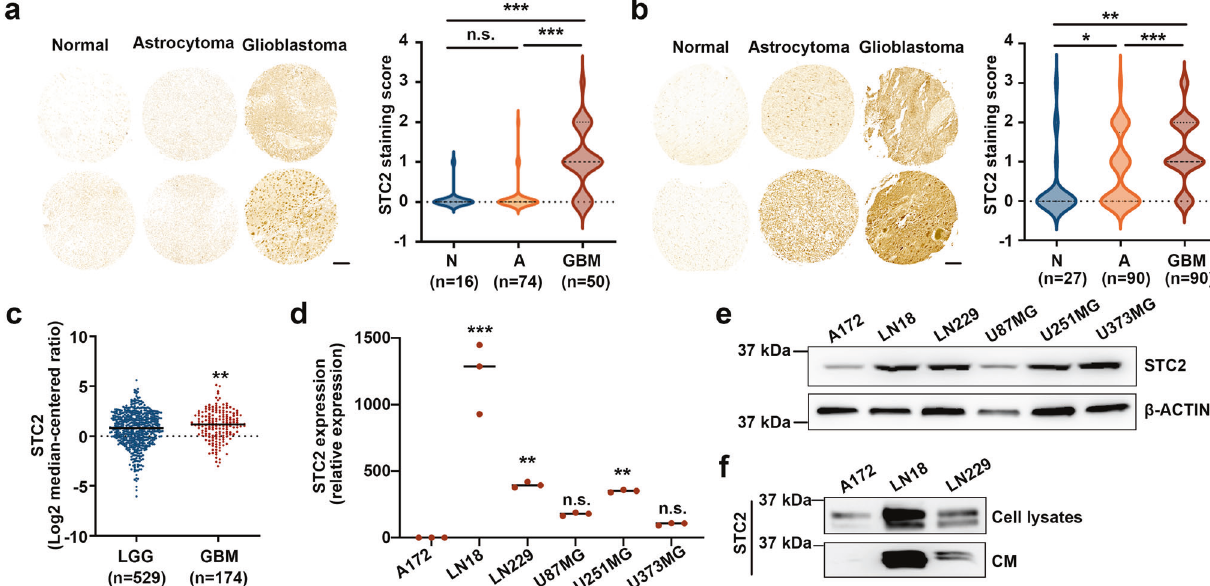
Fig. 1 Aggressive GBM expresses higher level of STC2. a , b Representative tissue microarray data of STC2 in clinical specimens ( a , GL2082; b , GL208, Biomax). The scale bar represents 100 µm. STC2 staining score from 0-4 were analyzed in different tissues. N, normal tissues; A, astrocytoma; GBM, glioblastoma. One-way ANOVA, * p < 0.05, ** p < 0.01, *** p < 0.001, n.s., no signi fi cance. c The levels of STC2 mRNA expression in low grade glioma (LGG) versus glioblastoma (GBM) tissues obtained from TCGA Research Network were analyzed. Unpaired t- test, ** p < 0.01. d The mRNA expression of STC2 in various glioblastoma cell lines were analyzed. After normalizing with 18 S rRNA in each sample, the relative mRNA levels were calculated using A172 = 1. Means ± SD; n = 3 biological replicates. Oneway ANOVA, ** p < 0.01, *** p < 0.001, n.s., no signi fi cance. e , f Representative images of Western blotting against STC2 and β -ACTIN in whole lysates of glioblastoma cell lines ( e ) and concentrated culture media (Conditioned media CM) ( f